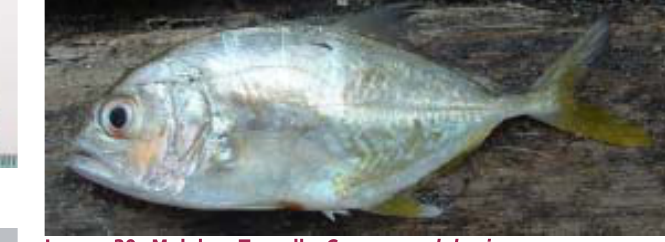
Image 30. Malabar Trevally Caranx malabaricus